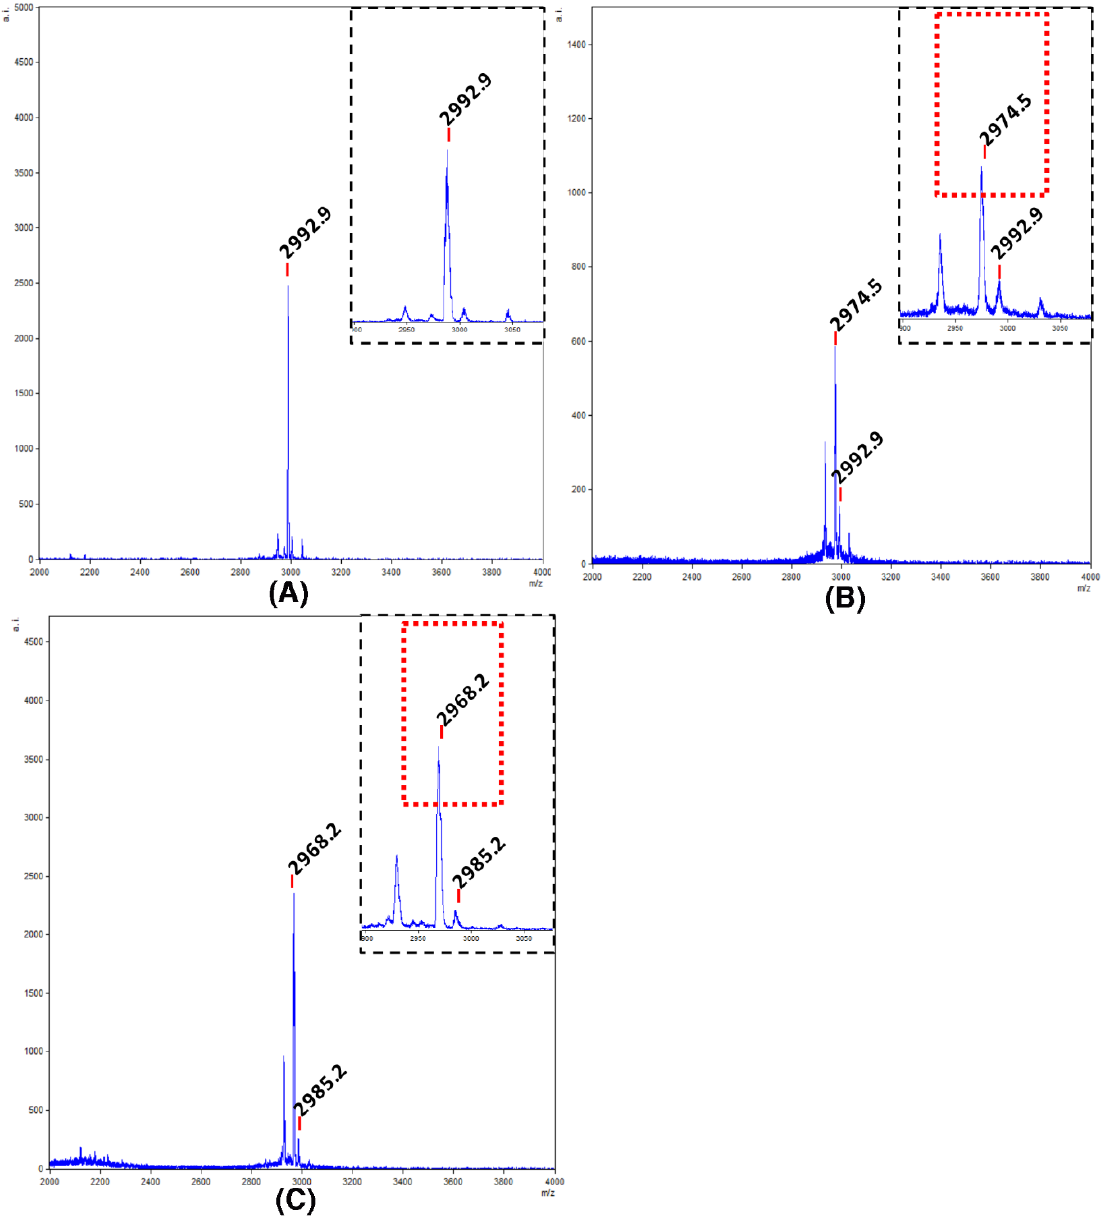
Figure 2. Mass spectrometric analysis of the cyclotide synthesis and folding. ( A ) MALDI-TOF spectra of linear unprotected cyclotide. Segmented quadrant shows a zoom of the molecular mass of the resulting linear peptide (2992.9 Da); ( B ) MALDI-TOF spectra of the unprotected cyclic peptide. Segmented quadrant shows a zoom of the peptide without the water molecule (2974.5 Da); ( C ) MALDI-TOF spectra of the target cyclotide. Segmented quadrant shows a zoom of the cyclic peptide without six hydrogen atoms from the three-disulfide bond formed (2968.2 Da).